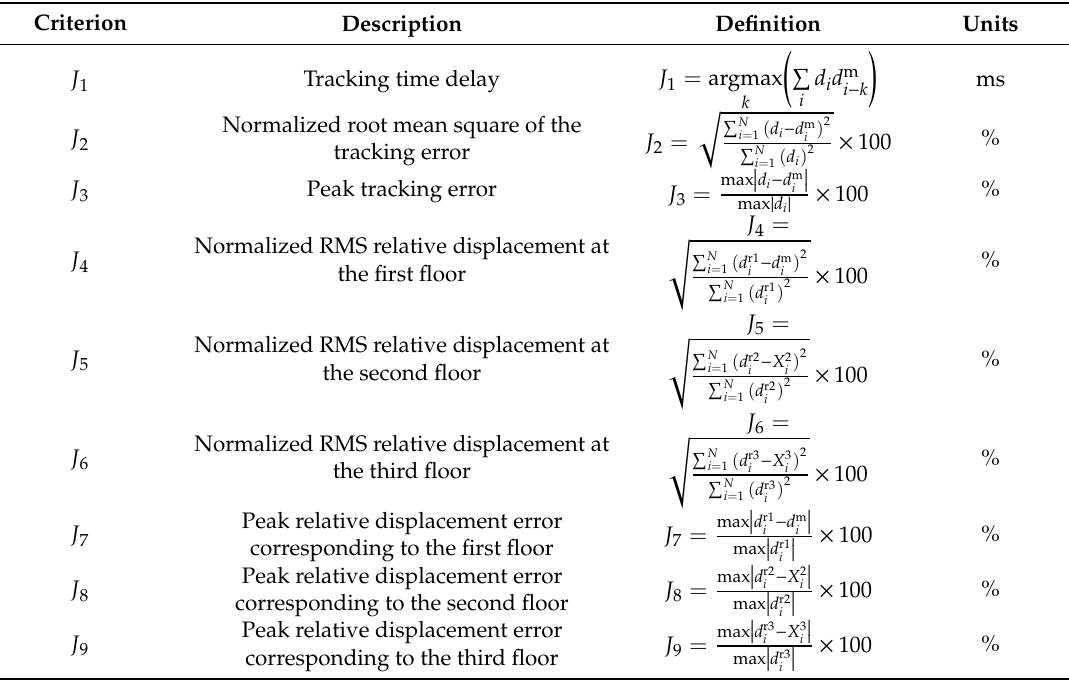
Table 3. Performance evaluation